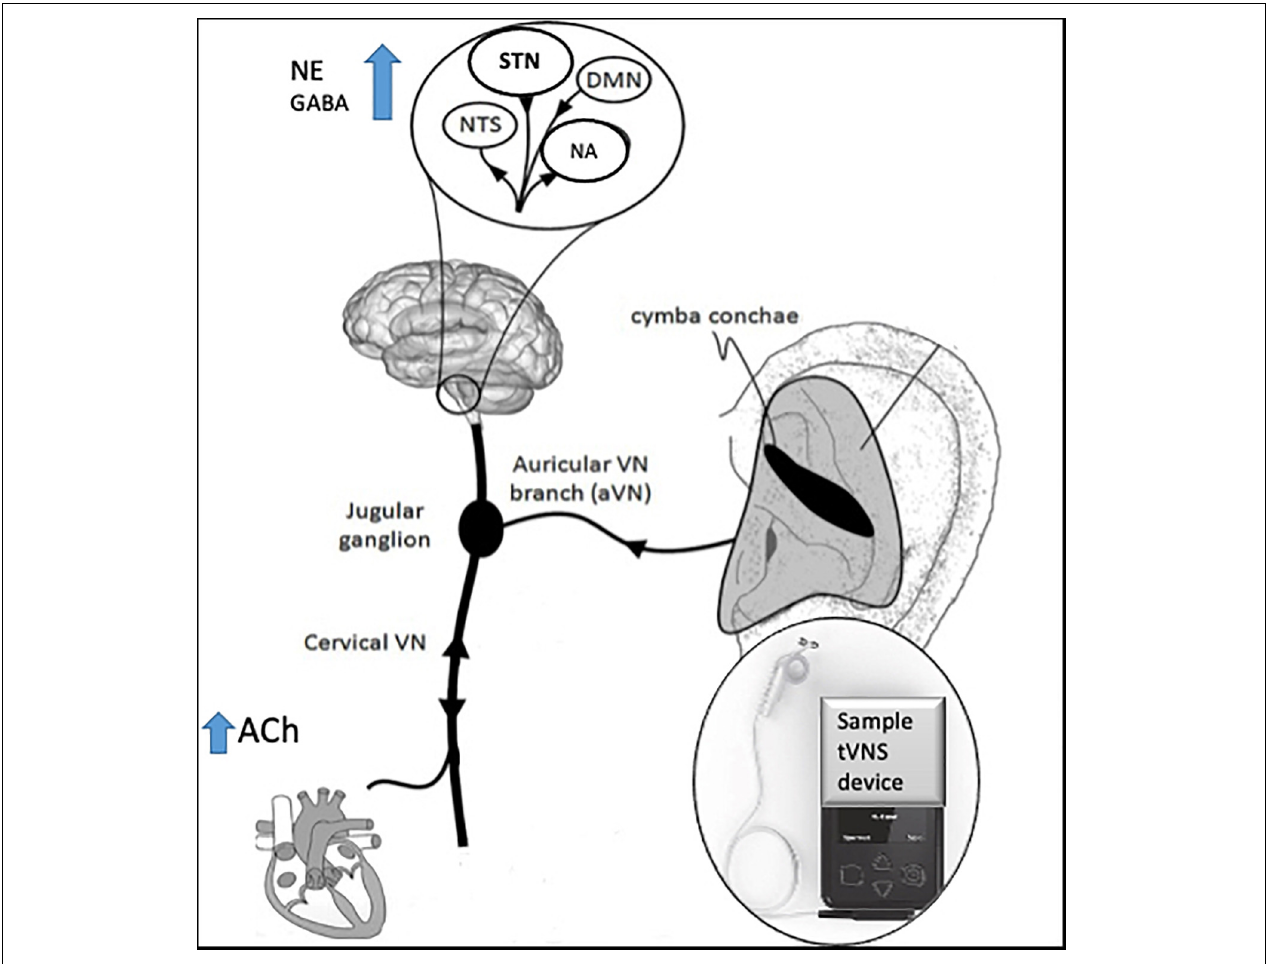
FIGURE 2 | Schematic diagram of innervation of ABVN and central projections, adapted with permission from Kaniusas et al.